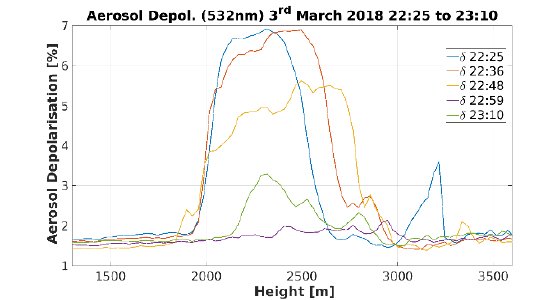
Fig.06: Same as Fig.04, except for